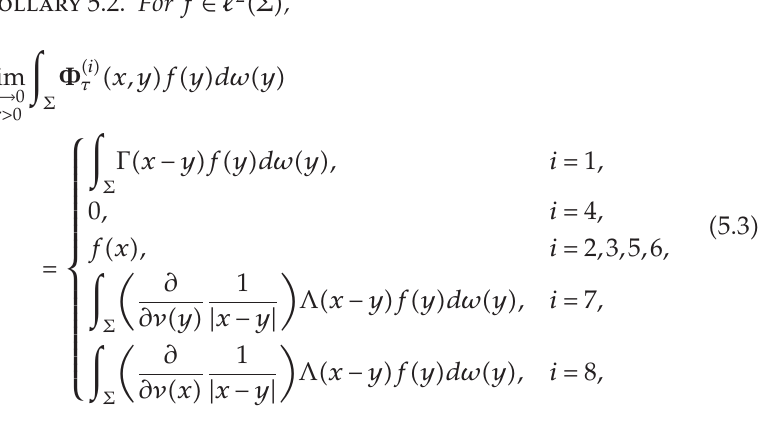
Figure 5.1 gives graphical illustrations of matrix norm, diagonal, and nondiagonal components of Φ